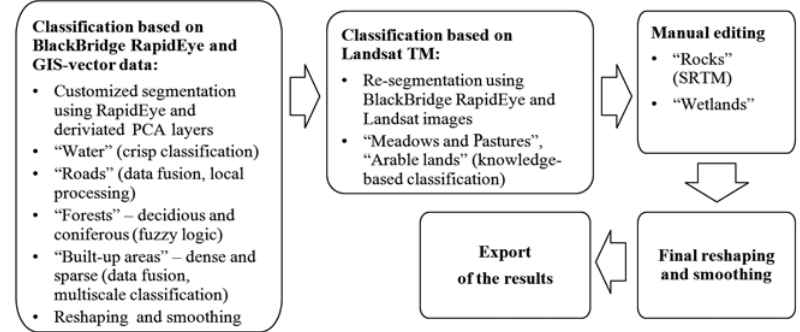
Fig. 2. GeoBia workflow for the selected czorsztyn (c) water catchment